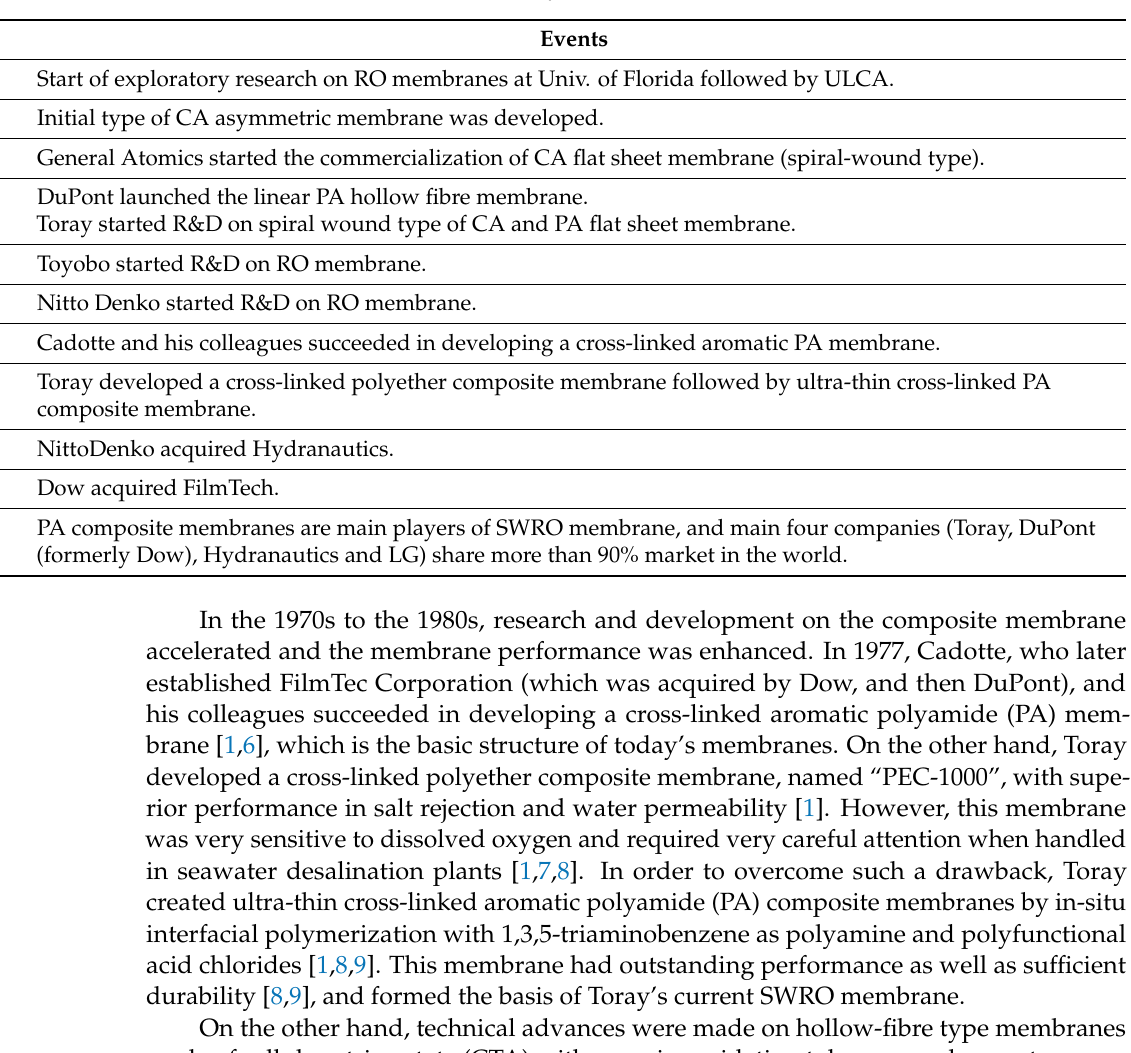
Table 1. The timeline of the basic history of SWRO